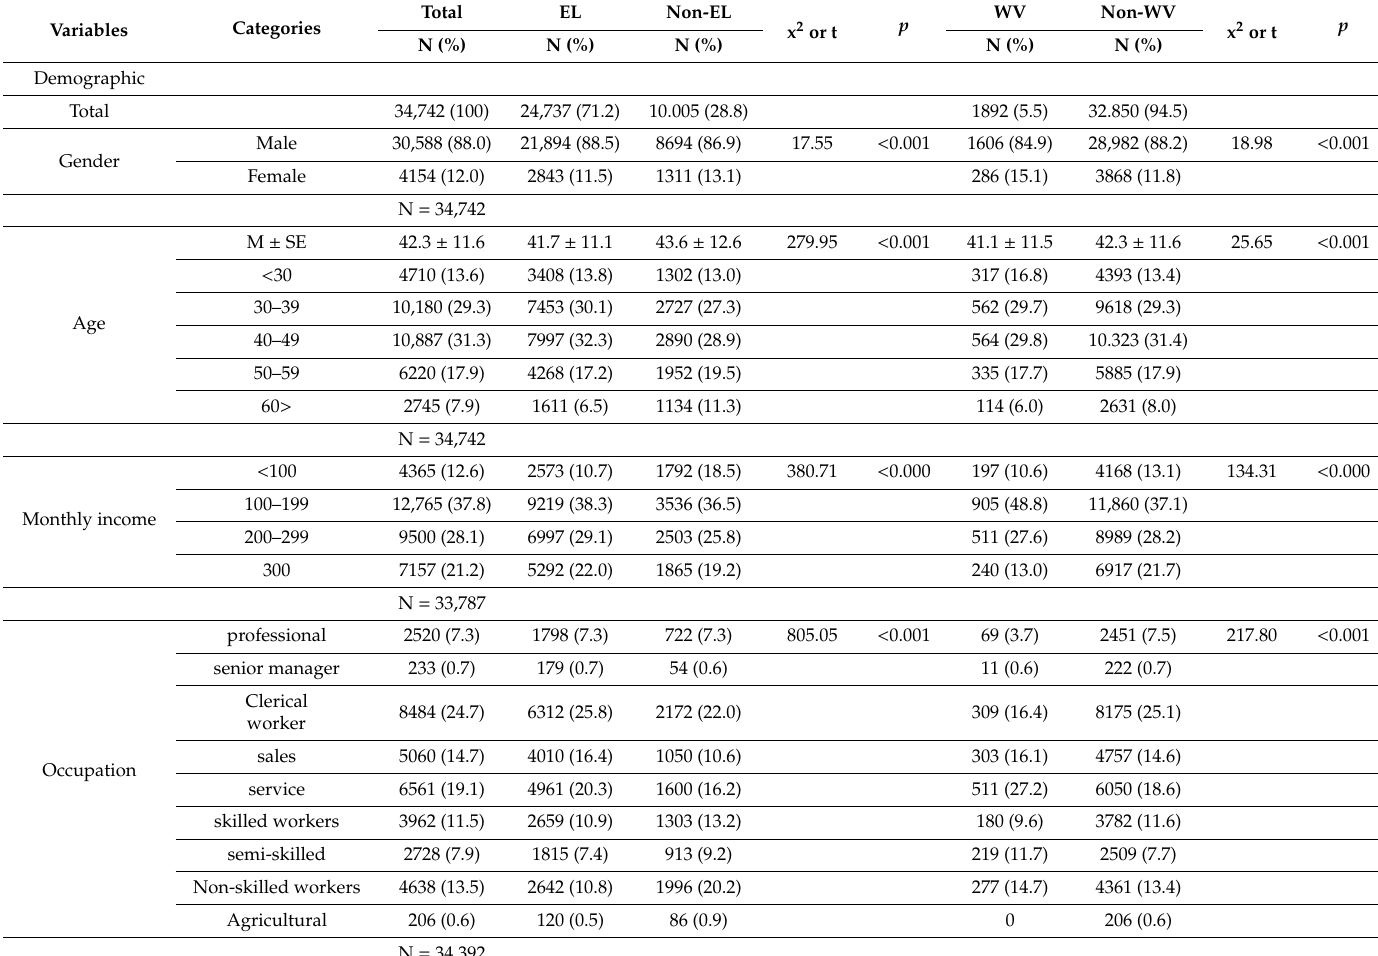
Table 1. Comparison of demographic